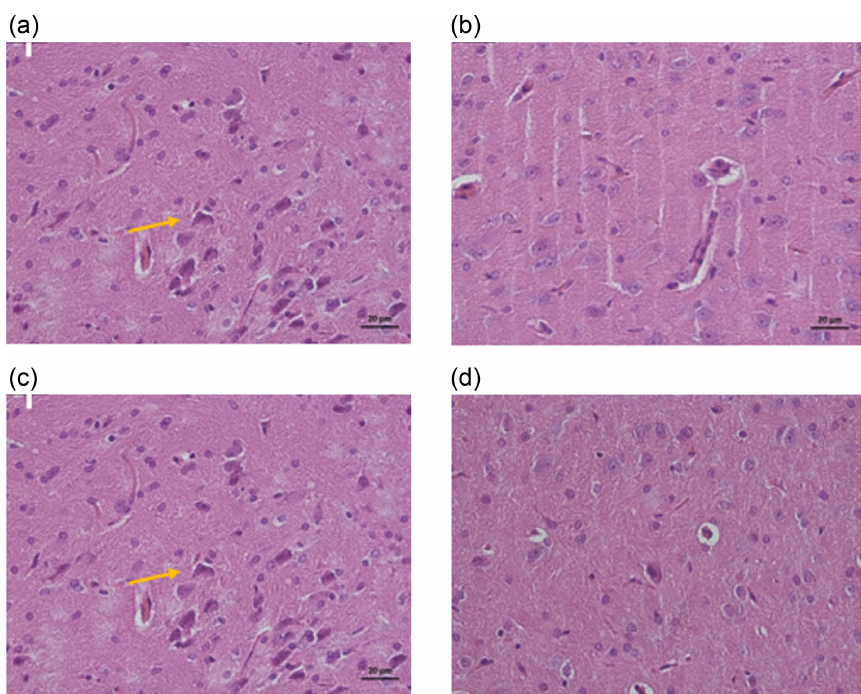
Figure 4. a-d. Histopathologic examination samples of substantia nigra of healthy group (a), control group (b), risperidone (c), and apomorphine (d) groups. In healthy group: significantly lower number of degenerated neurons. In the control group: there are very some degenerated neurons. In risperidone group: the number of degenerated neurons is much higher than other groups. In aqpomorphine group: significantly, there are few degenerated neurons than the other